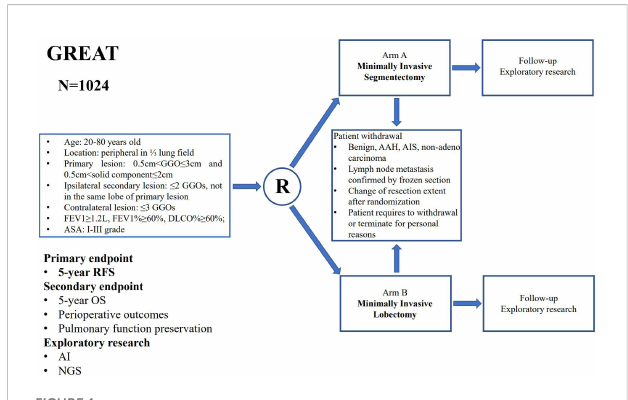
FIGURE 1 The study fl owchart of the Ground Glass Opacity Resection Extent Assessment Trial